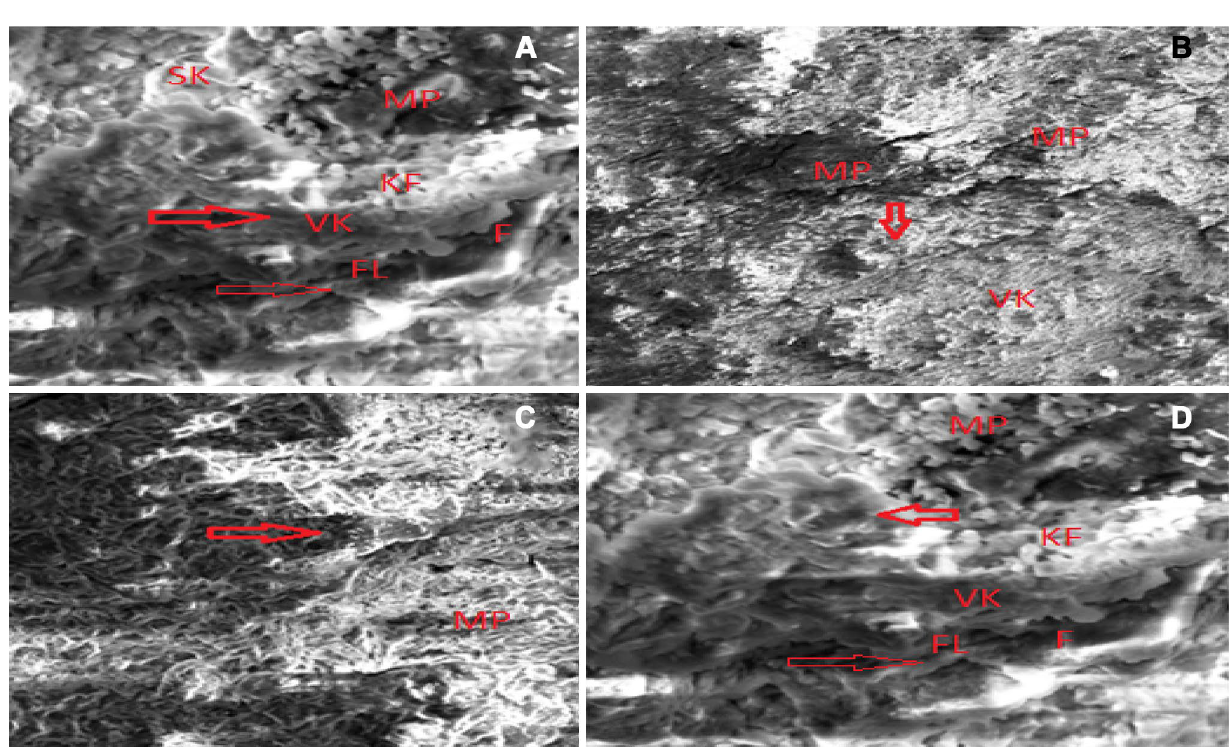
Fig. 16 SEM photomicrograph for Ayede-Ajegunle at depth range of 54–57 m. F fracture, FL fracture line, MP micro pores, SK sheet kaolinite, KF K-feldspar, VK vermiform kaolinites. Magnification a = ×50, b = ×100, c = ×750, d =